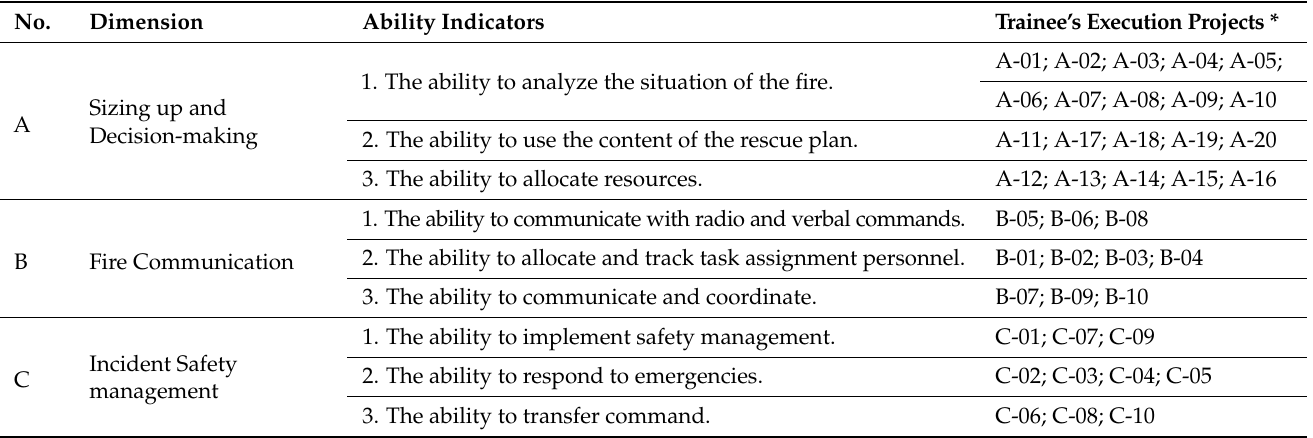
Figure 8. ( a ) Realistic building and street. ( b ) Historical case simulations in VR. ( c ) Interactive locations of VRST trainees, facilitators, instructors, and evaluators (operation unit used as example). Table 2. Evaluation Index to Objectively Evaluate Trainees’ Fire Command